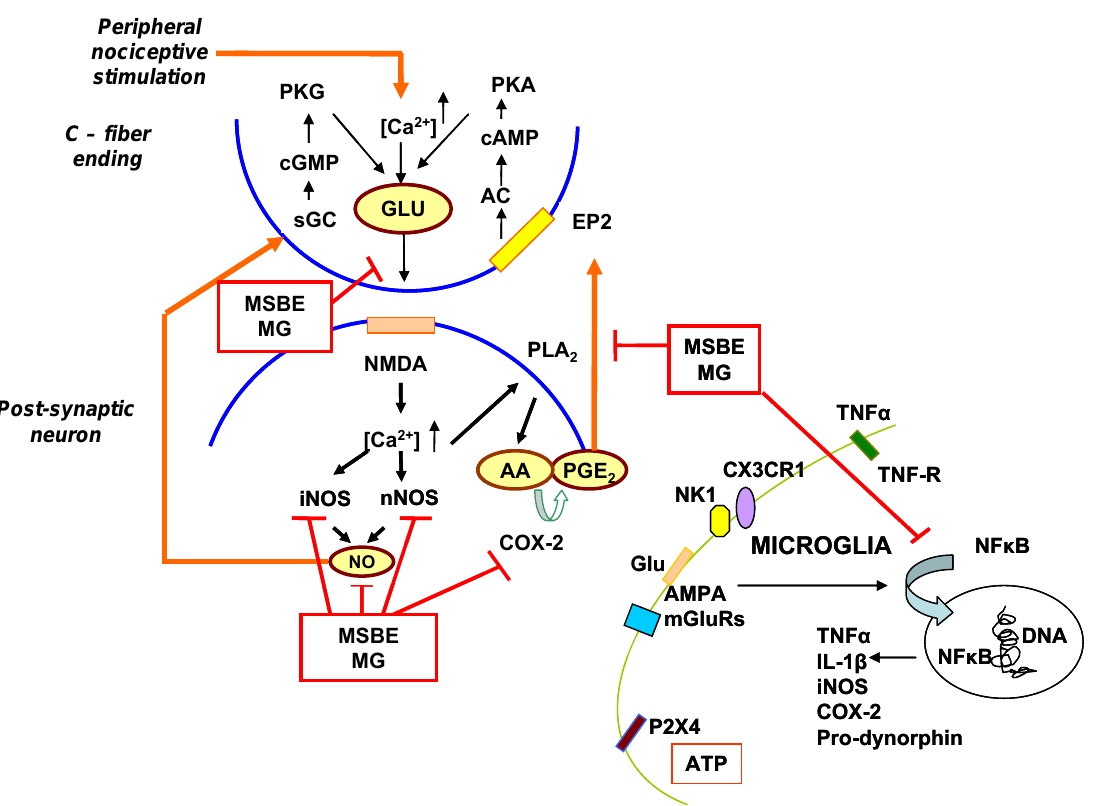
Figure 1. Schematic diagram illustrating the hypothetical molecular mechanism of Mangifera indica L aqueous stem bark extract (MSBE) and its isolated glucosylxanthone mangiferin (MG) in spinal cord nociceptive processing. Modified diagram according to Vetter et al .